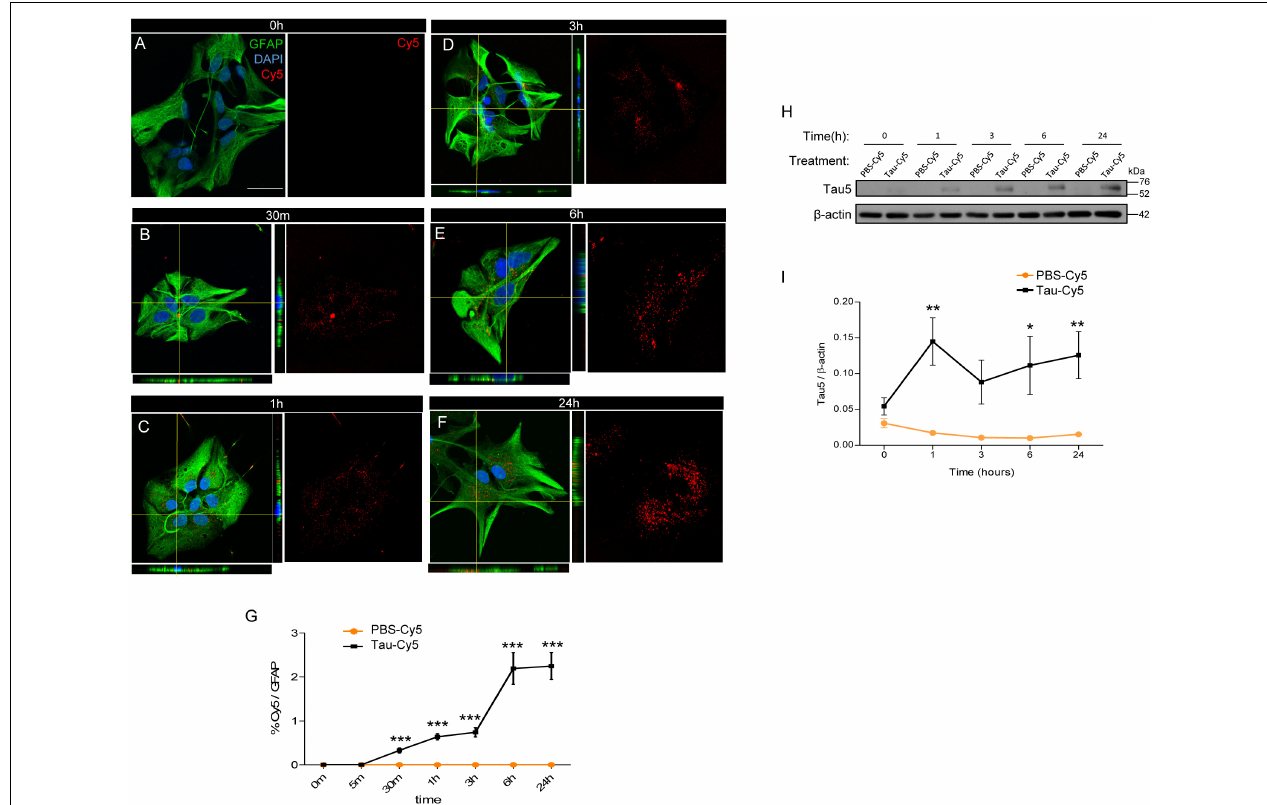
FIGURE 1 | Astrocytes internalized extracellular Tau in vitro . Astrocytes derived from primary cultures were incubated with Tau-Cy5 at different time points (A – G) . (A – F) show representative immunofluorescence images of cells stained for GFAP (green) and Tau (red). Representative images of times 0 h (A) , 30 min (B) , 1 h (C) , 3 h (D) , 6 h (E) , and 24 h (F) are shown. (G) shows quantification of results from immunofluorescence analysis showing % Cy5/GFAP fluorescence intensity present in cells treated with Tau-Cy5 relative to the control PBS-Cy5. (H) western blot and (I) quantification, of Tau in cell lysates from 0 to 24 h. Means and SE, PBS 0 h = 0.03 ± 0.006; Tau 0 h = 0.05 ± 0.01; PBS 1 h = 0.02 ± 0.002; Tau 1 h = 0.14 ± 0.03; PBS 3 h = 0.01 ± 0.002; Tau 3 h = 0.09 ± 0.03; PBS 6 h = 0.01 ± 0.003; Tau 6 h = 0.11 ± 0.04; PBS 24 h = 0.01 ± 0.002; and Tau 24 h = 0.12 ± 0.03. An N = 5 independent experiments were performed. Bars show means ± SE. ∗ p ≤ 0.05, ∗∗ p ≤ 0.01, and ∗∗∗ p ≤ 0.001. Scale bar, 50 µ